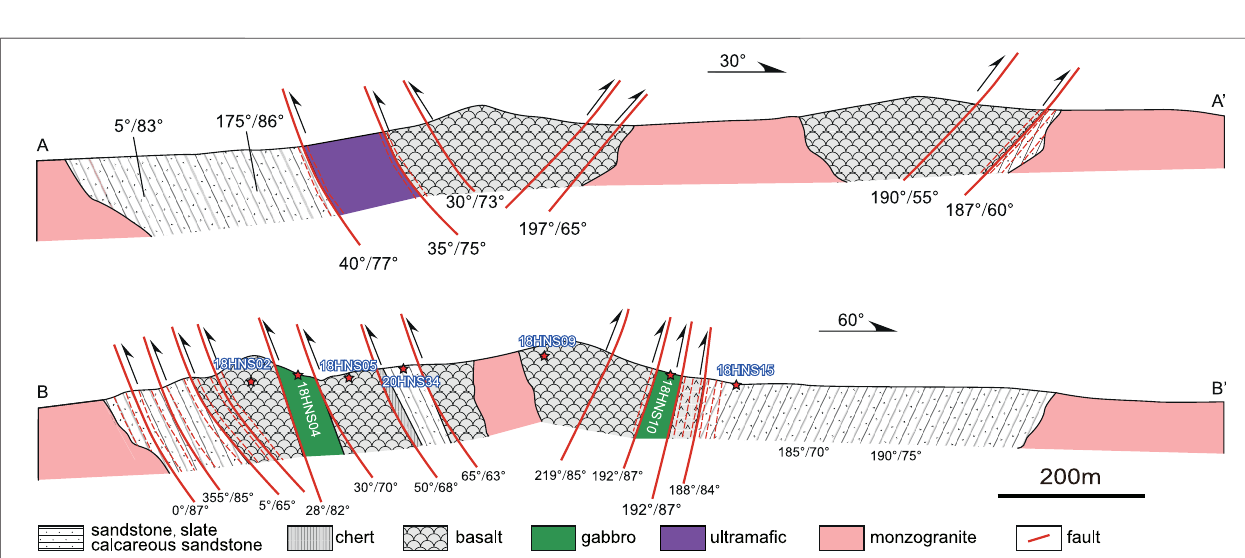
Tarim and North China cratons along the South Tianshan – Solonker suture zone ( Ş engör et al., 1993; Xiao et al., 2018). The South Tianshan and Solonker belts are